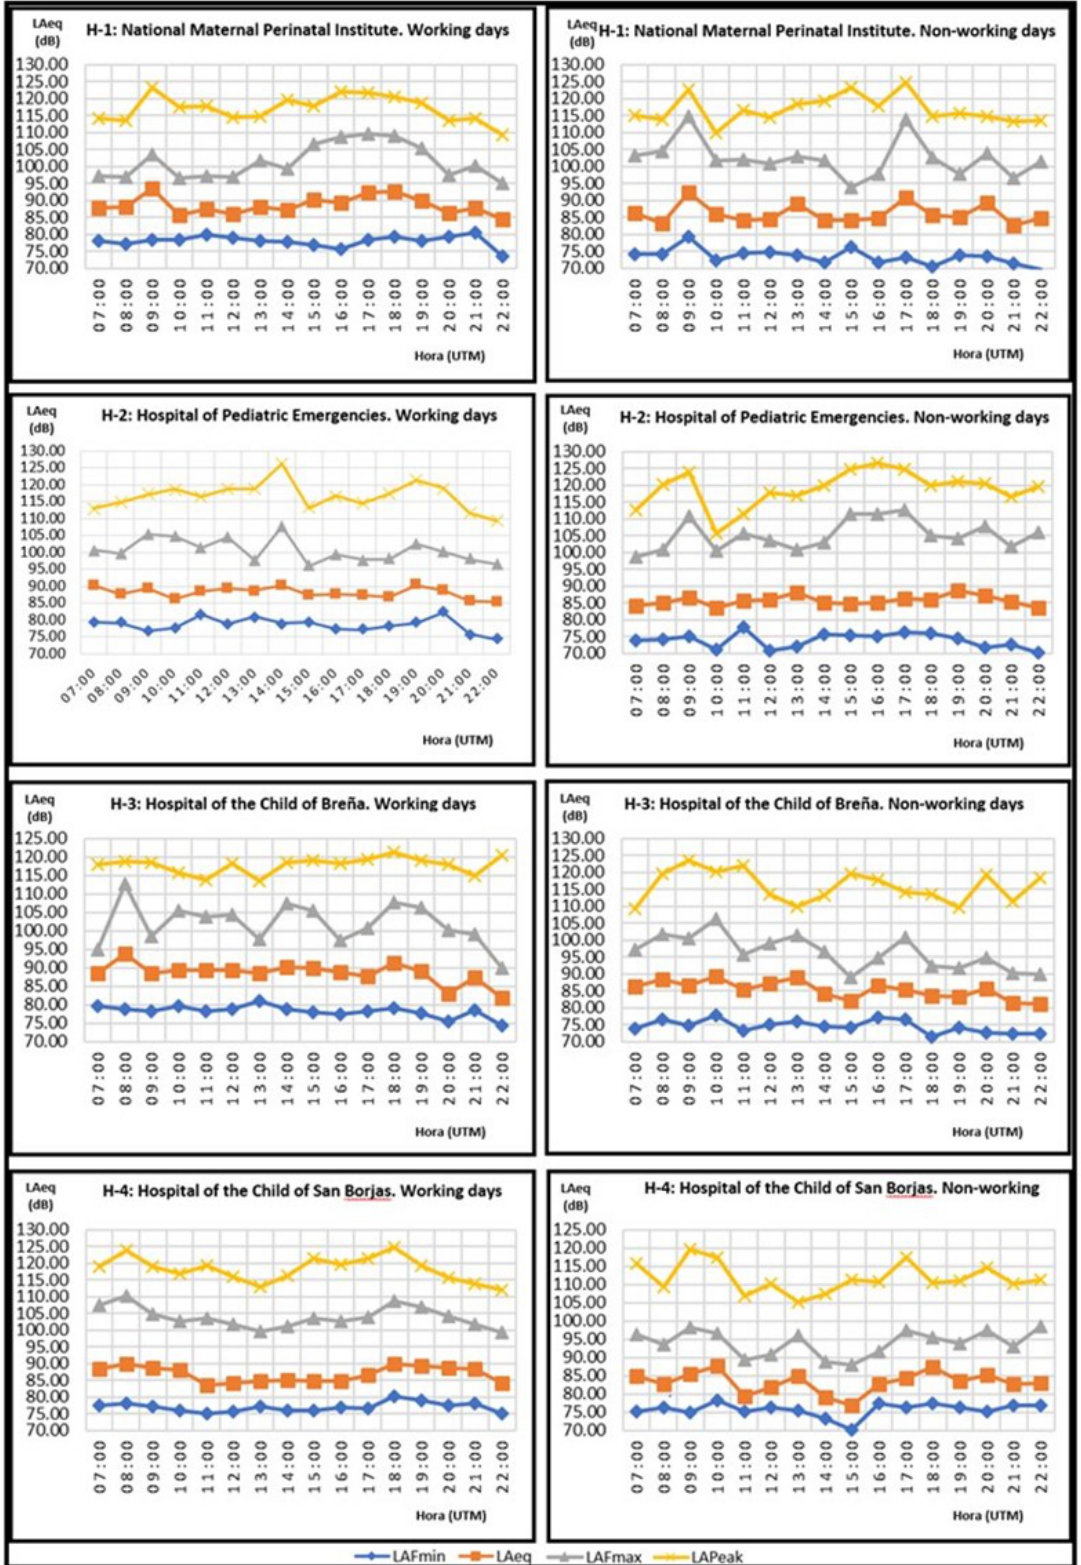
Figure 3: Behaviour of environmental noise daytime perimeter at four hospitals on working and non-working